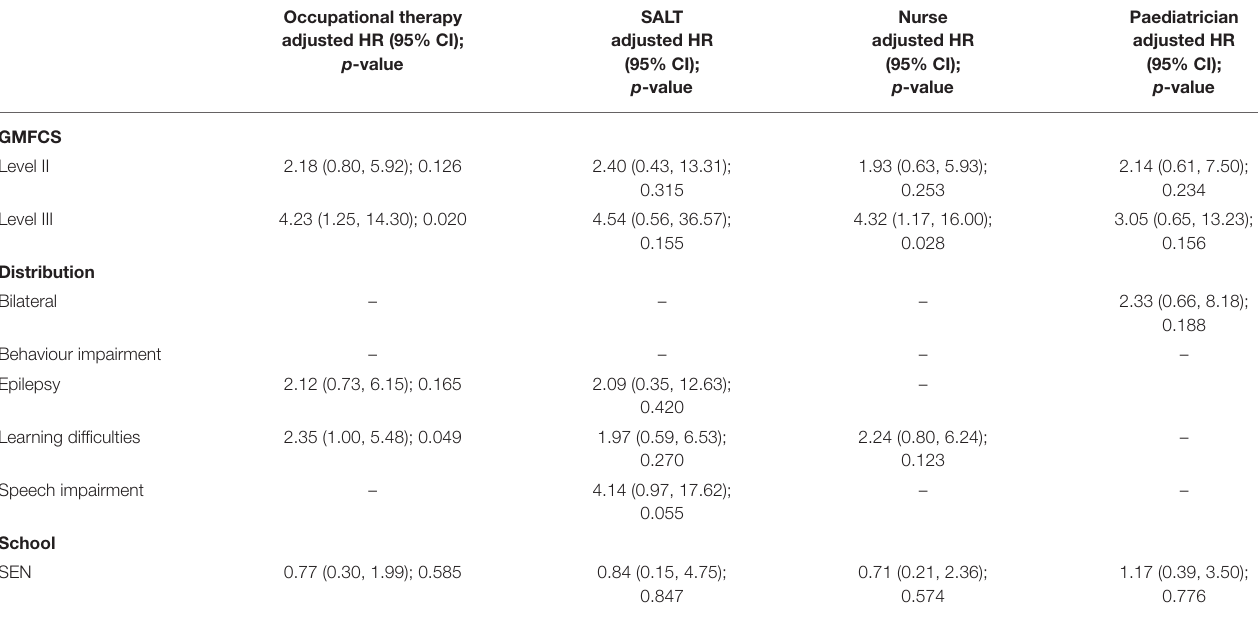
TABLE 5 | Adjusted associations with at least one visit to an occupational therapist, speech and language therapist, nurse, optician, paediatrician.